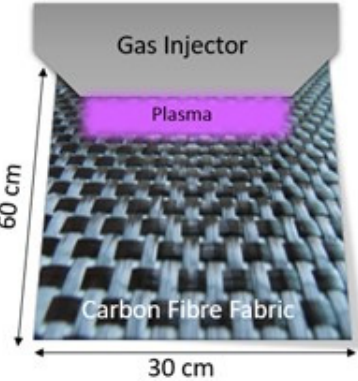
Figure 1. Air pressure plasma treatment representation.